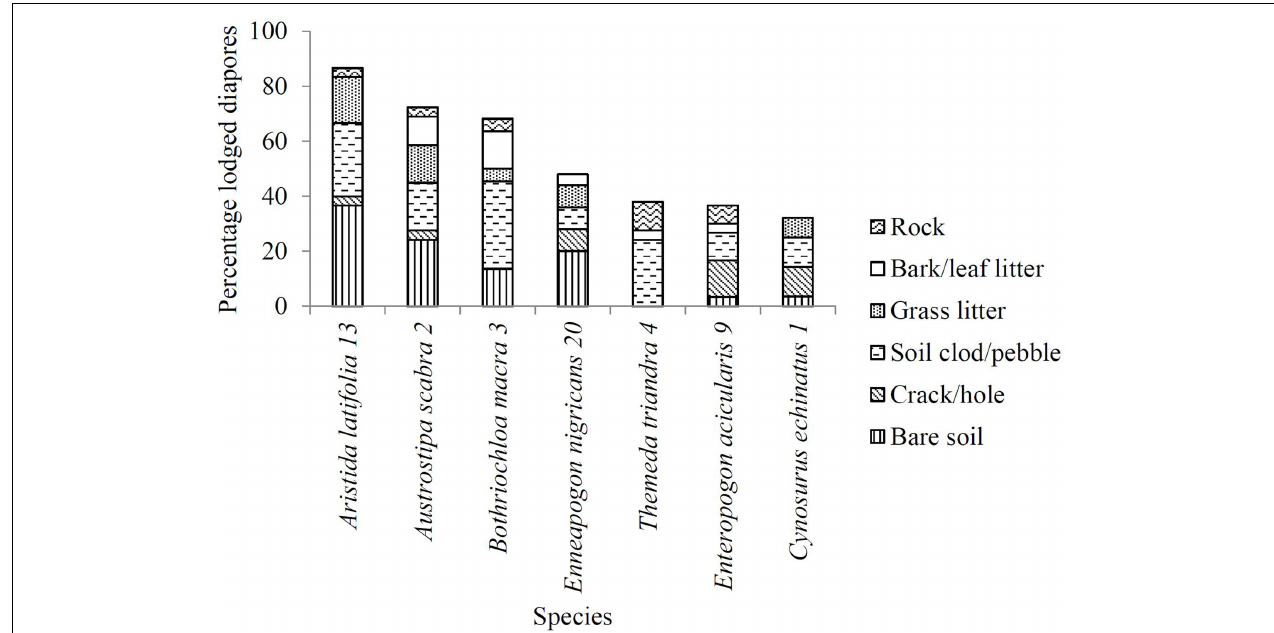
FIGURE 7 | The percentage of diaspores that lodged at each of the different microsites in the natural experiment after 21 days. Species name is followed by awn type (see Table 1 ).